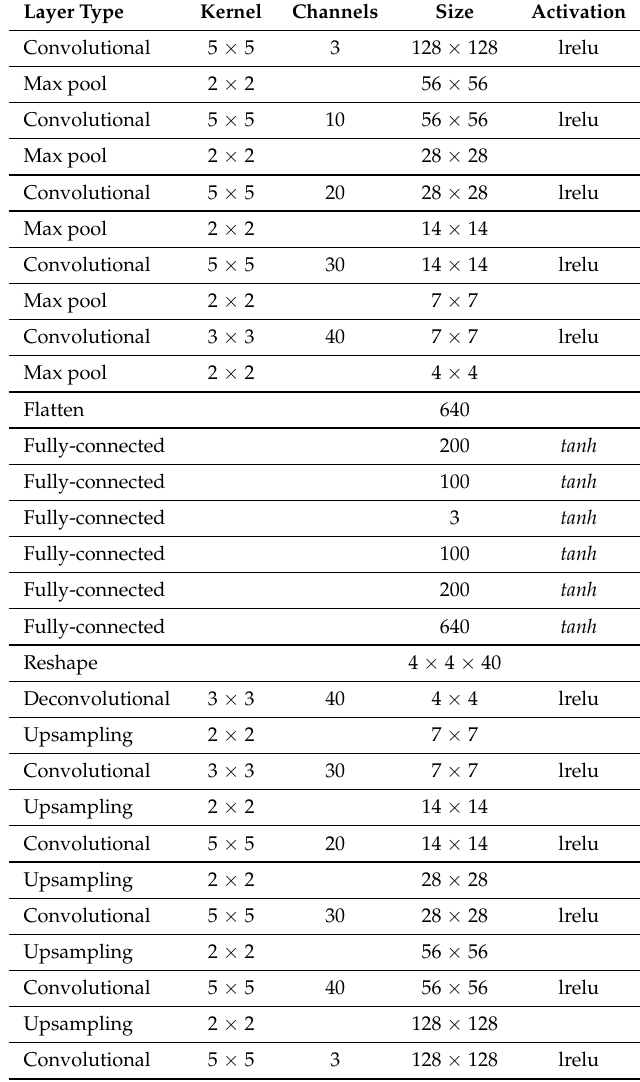
Figure 8. The figures show cross-modality manifold alignment using the asymmetric PDAE using four versions of the data with different percentages of correspondence pairs (10%,30%,50%,100%). The corresponding quantitative alignment errors ∆ and associated standard deviations σ in parentheses are displayed in the subcaptions next to the correspondence percentage numbers. Table 5. Shown is the structure of the convolutional autoencoder part of the asymmetric PDAE, which was used to align our cross-modality pendulum data. The input layer is at the